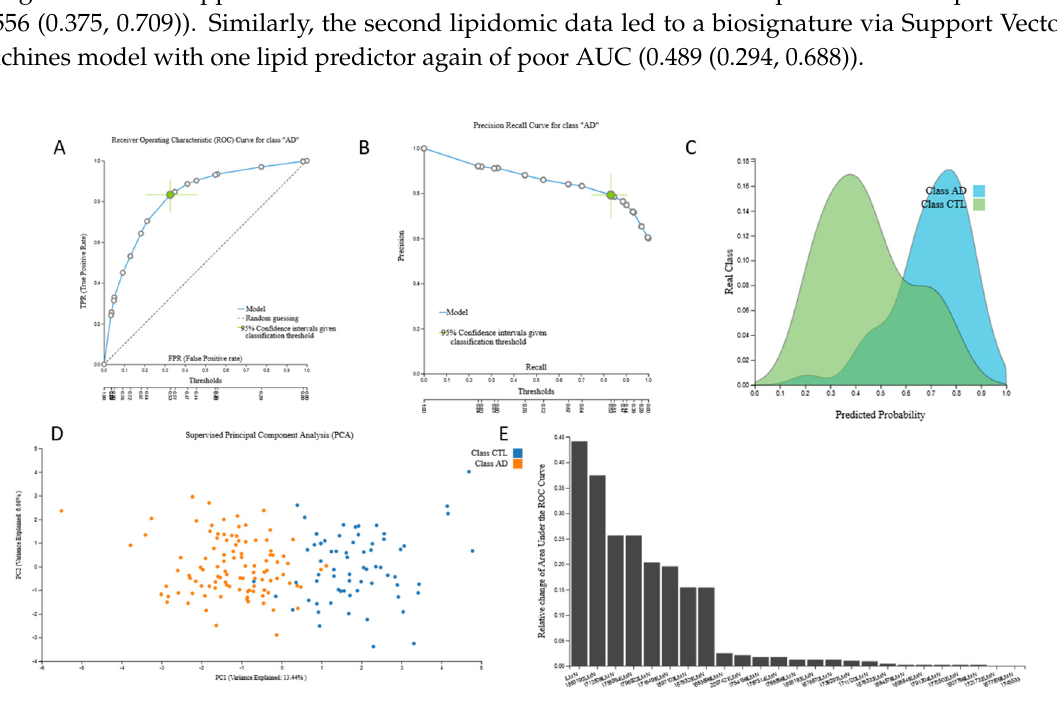
Figure 5. Validation of 38,327 ‐ feature mRNA transcriptomic sub ‐ dataset (test) signature performance: ( A ). Receiver Operating Characteristic (ROC) Curve for AD class, ( B ). Precision ‐ recall